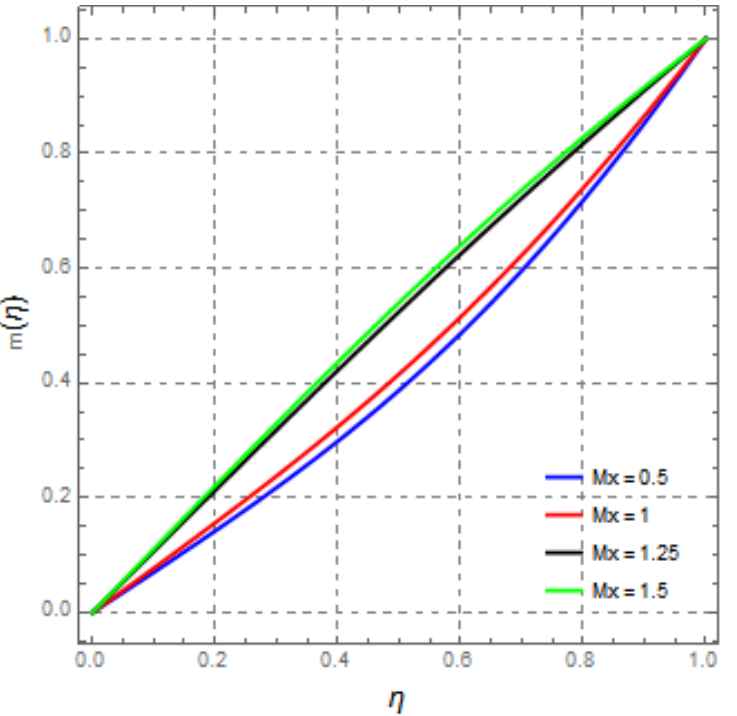
Figure 11. Impact of magnetic field strength M x on magnetic field component m , keeping S z = − 1.75, M y = 3, R m = 1, and S = 1.